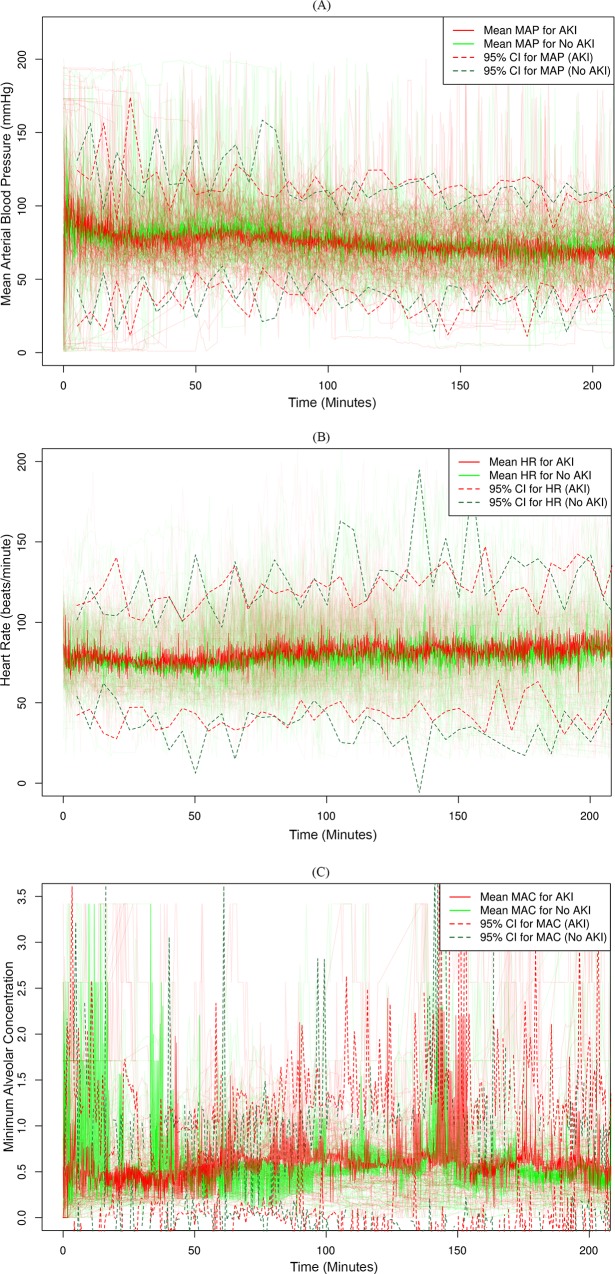
Intraoperative physiological time series variations stratified by the occurrence of acute kidney injury.Intraoperative physiological time series variations for 100 randomly selected patients during the first 200 minutes of surgery stratified by the occurrence of acute kidney injury (AKI) within the first seven days after surgery. Mean and 95% Confidence Interval (CI) stratified by the occurrence of AKI are shown for (A) intraoperative mean arterial blood pressure, MAP (mmHg), (B) intraoperative heart rate, HR (beats/minute), and (C) intraoperative mean alveolar concentration of anesthetics, MAC.